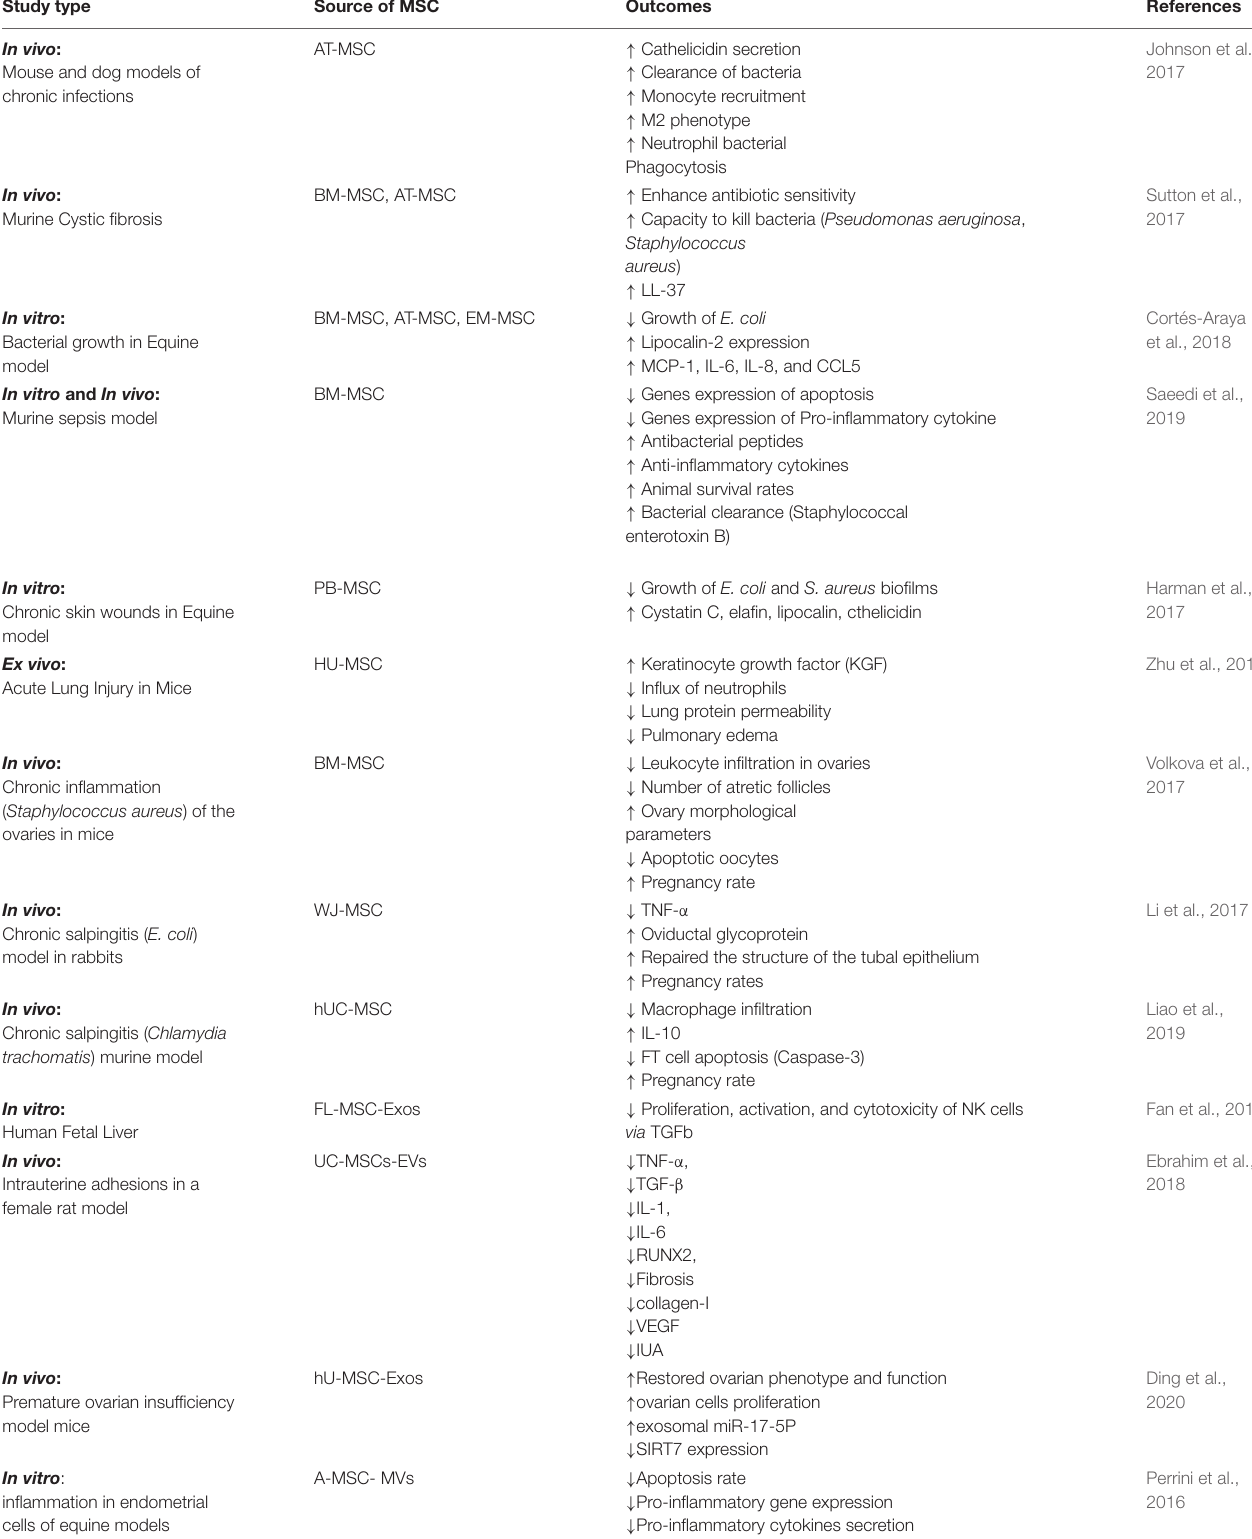
TABLE 1 | Antibacterial and Immunomodulatory Effects of MSCs and MSC-Exos in in vitro and in vivo